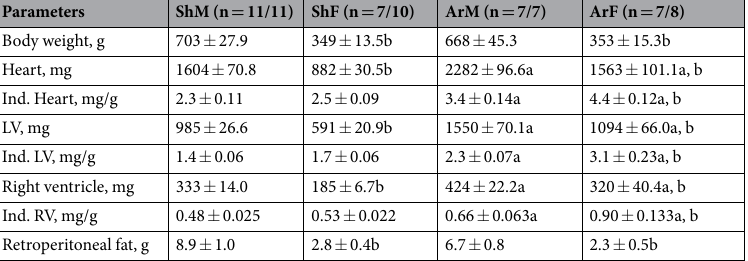
Table 1. Animal characteristics at the end of the study. Sham: sham-operated controls; Ar: aortic regurgitation; M: male rats and F: female rats. LV: left ventricle, RV: right ventricle and Ind. indexed. Values are expressed as the mean ± SEM. The number of animals per group is indicated in parentheses. a p < 0.05 vs. the corresponding sham group and b p < 0.05 vs. the corresponding male